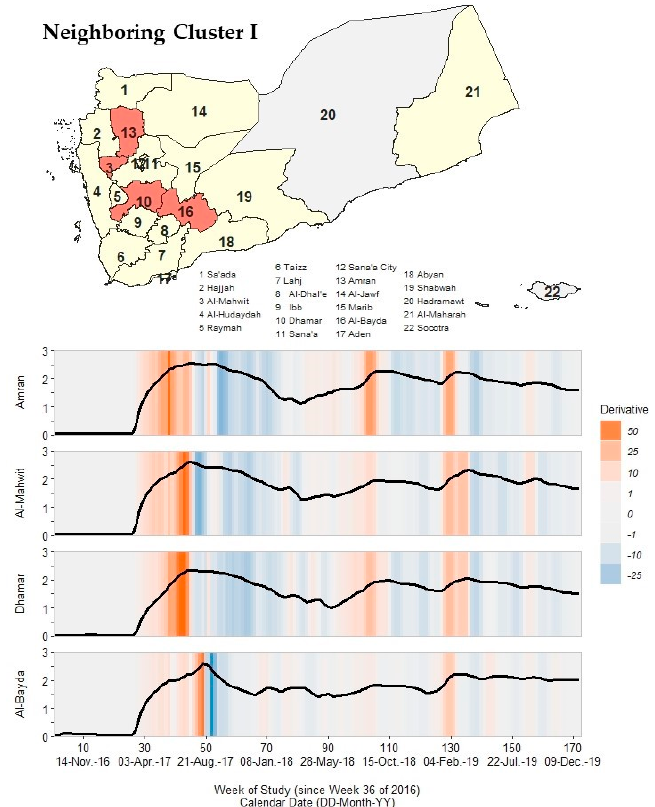
Figure 5. A map of Yemen with a shaded outbreak cluster including Amran, Al-Mahwit, Dhamar, and Al-Bayda, and a stacked time series plot and heatmap for each governorate’s outbreak signature. Top panel: the governorate-level map indicates governorates within the cluster in orange, remaining governorates within our study in yellow, and excluded governorates in grey (the Hadramaut and Socotra island governorate). Bottom panel: stacked time series plots for each governorate within the cluster. All plots show log10-transformed smoothed rates produced using Kolmogorov–Zurbenko adaptive filters from Week 36 (4–11 September) of 2016 through Week 52 (23–29 December) of 2019. Smoothed rates (laboratory-confirmed cholera cases per 100,000 persons) were estimated using the best performing smoother. Backgrounds for each plot are heatmaps of trivial derivative values, ranging from − 25 (dark blue) to +50 (dark orange) with values near zero in grey. Time series plots have a common horizontal axis of time reported in weeks since Week 36 of 2016 (defined as study Week 0). All rates and trivial derivates were calculated for the 172 weeks of time series. Data used to develop this visualization are reported in Table 1 and Supplementary Excel Table